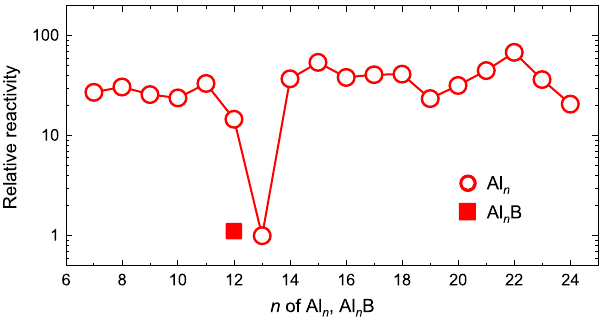
Fig. 3 Size dependent relative reactivities of Al n ( n = 7 – 24) and B@Al 12 on the HB-HBC substrate against the O 2 exposure. The oxidative reactivity rates for Al n on the HB-HBC substrate are plotted (red open circles), and a clear local minimum is observed at n = 13 along with a small minimum at n = 19, while there is no apparent local minimum at n = 23. B@Al 12 shows a low oxidative reaction rate (red solid square), similar to that of Al 13